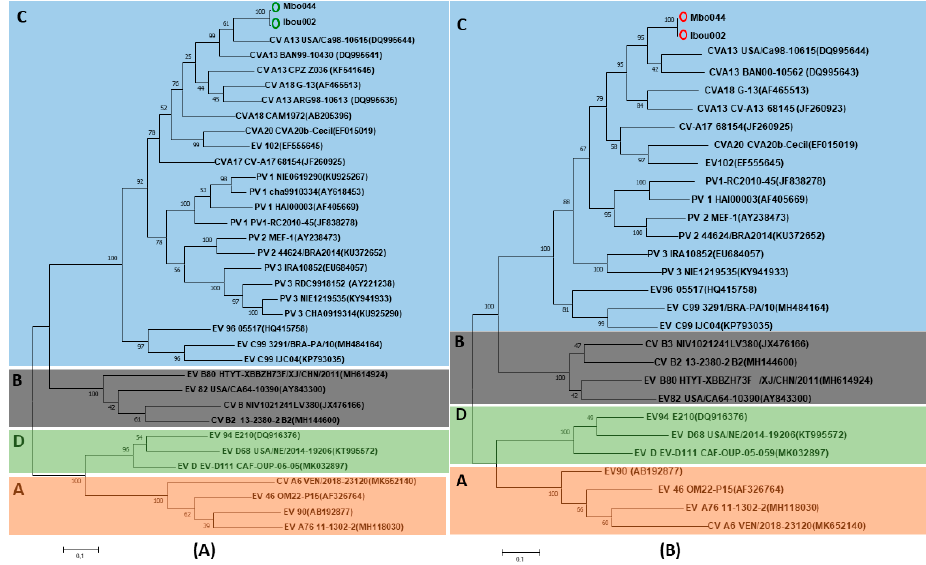
Figure 5. Phylogenetic tree based on the complete VP1 ( A ) and VP2 ( B ) sequences of the human enterovirus serotypes and EV strains in this study. Isolates in the present study are indicated in green (VP1) and red (VP2) circles while EV-C isolates previously described in the Congo and elsewhere are in blue.